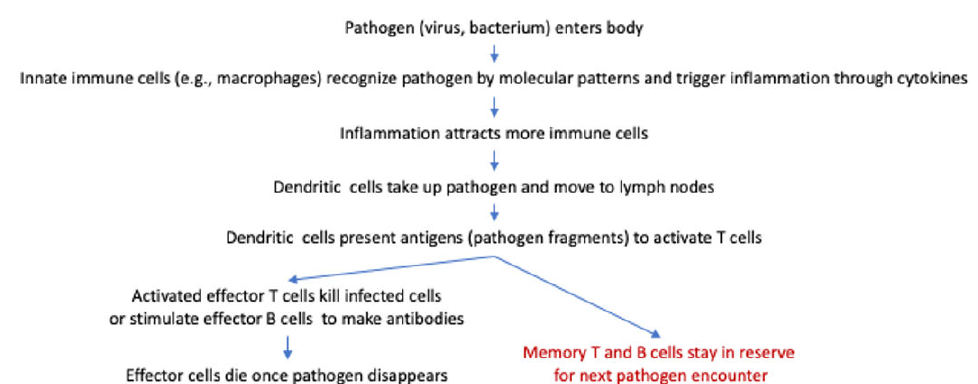
Figure 1. The course of an antiviral or antibacterial immune response is simplified. The pathogen enters the body and is recognized by the innate immune cells through its specific molecular patterns, the cytokines then triggering an inflammation. This inflammation attracts more immune cells, with the pathogen being taken up by dendritic cells and moved to the lymph nodes. The dendritic cells then present antigens that activate effector T cells and memory T cells. The effector T cells either kill the infected cells or stimulate effector B cells to make antibodies, with the effector cells dying after the pathogen is eliminated. In contrast, memory T and B cells remain in reserve to be used in the future encounter of the same